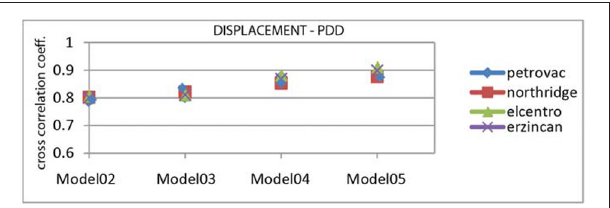
FIGURE 4 | Cross correlation coefficient of PDD displacement for MODEL02 -MODEL05.